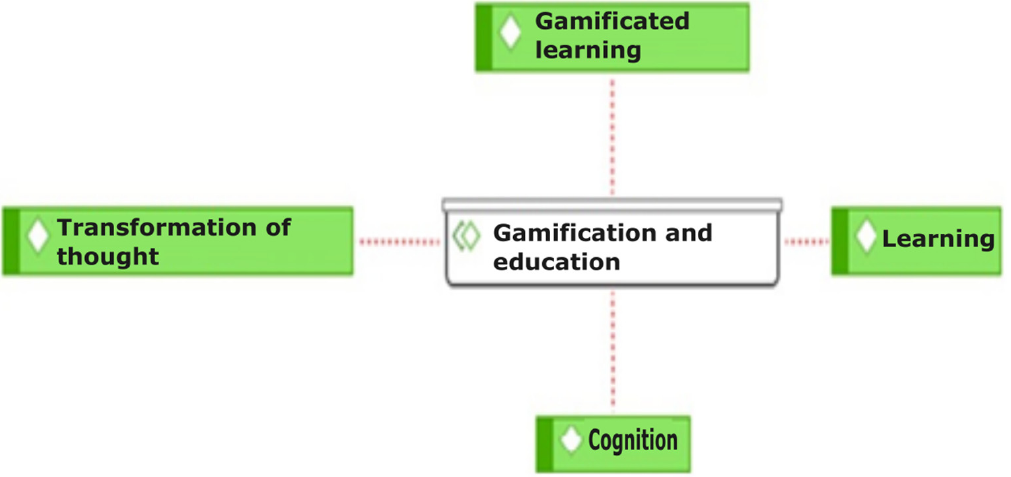
Figure 5. Edutainment and education. Source: Self-generated with the use of ATLAS.ti Software.